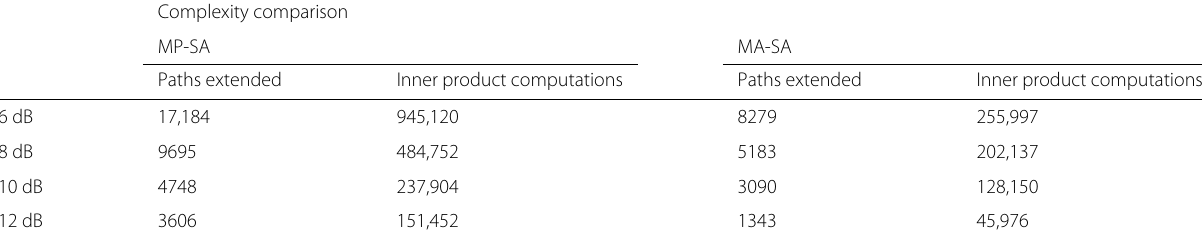
Table 2 Computational complexity comparison between MP-SA and